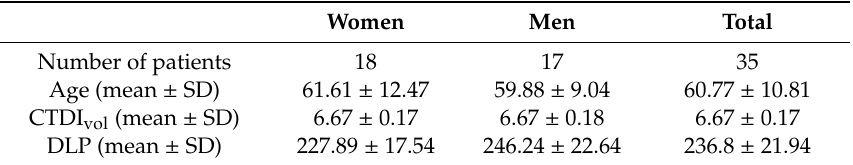
Table 1. Demographic characteristics of studied